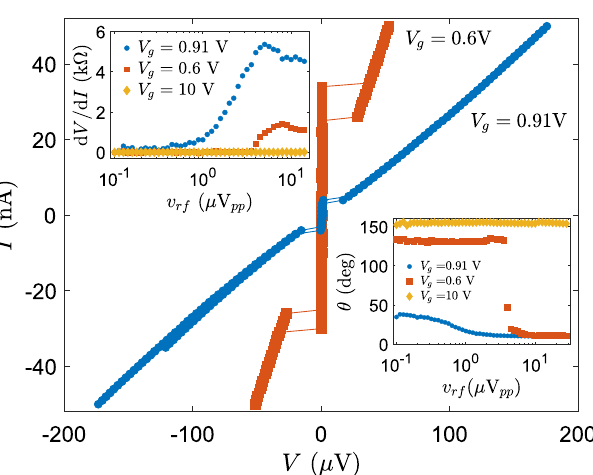
2 0.91 V (CNP) and at V 0.6 V ( n 2.3 10 10 cm ) at 35 mK g = g = − − = × 0.33 µ V pp on the sample from the oscillator of the lock-in =